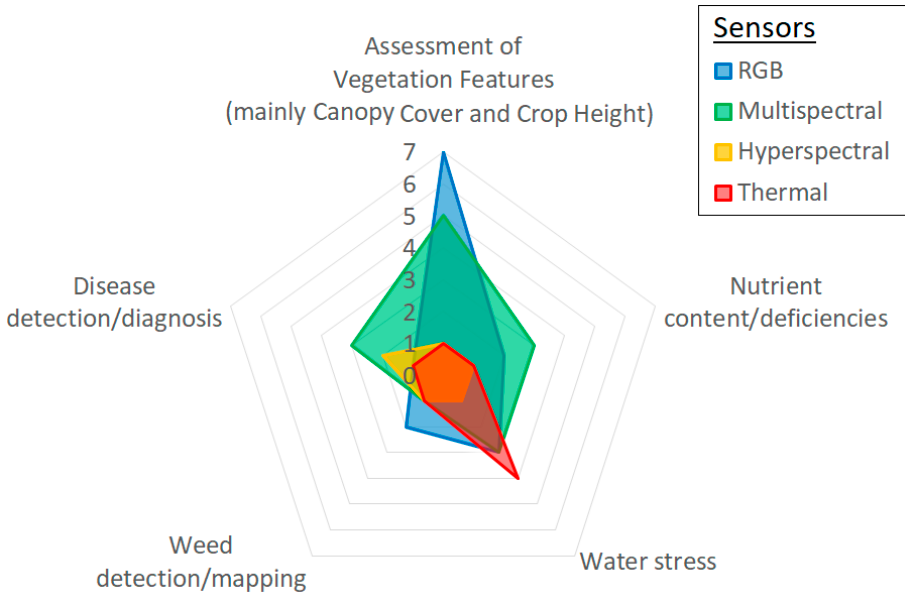
Figure 1. Sensors used in the experiments performed in this SI according to agricultural and forestry objectives.